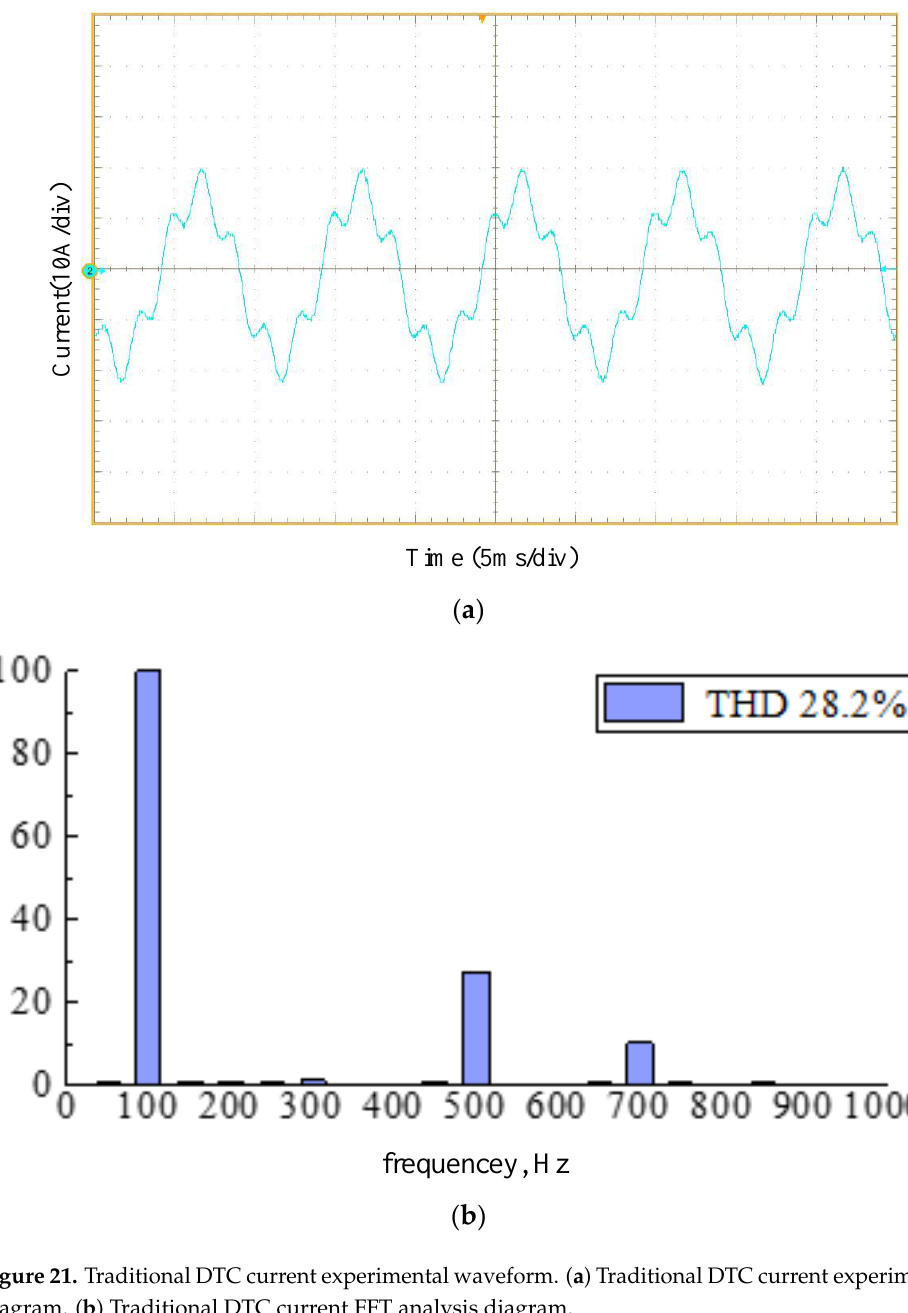
Figure 21. Traditional DTC current experimental waveform. ( a ) Traditional DTC current experimental diagram. ( b ) Traditional DTC current FFT analysis diagram.